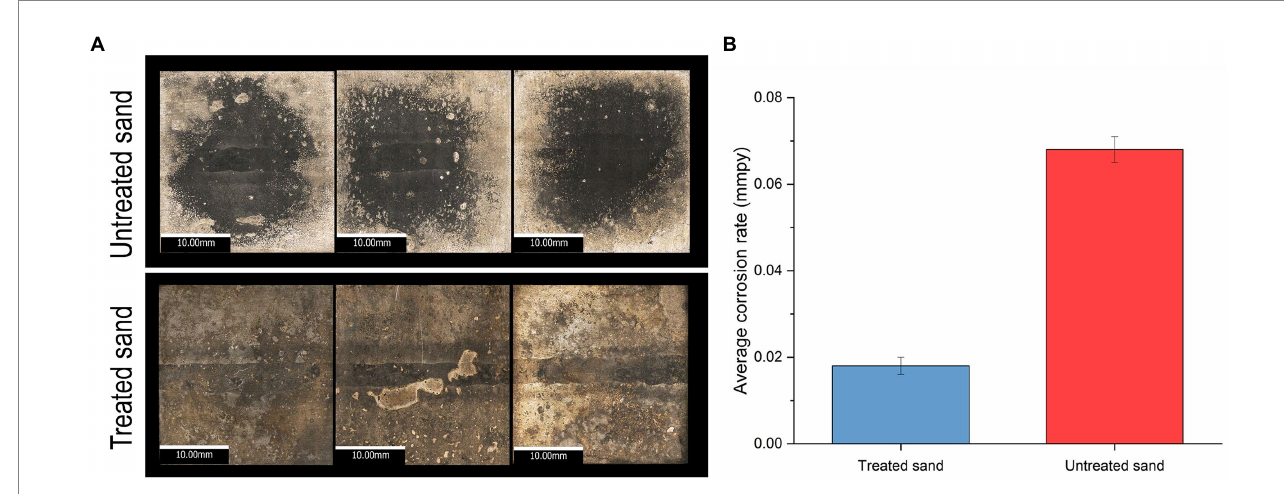
FIGURE 2 Uniform corrosion of carbon steel in a 4 weeks UDMC test with two chemically different sand deposits. (A) Visible-light microscopy images of metal samples at 5X resolution. (B) Average general corrosion rates by weight